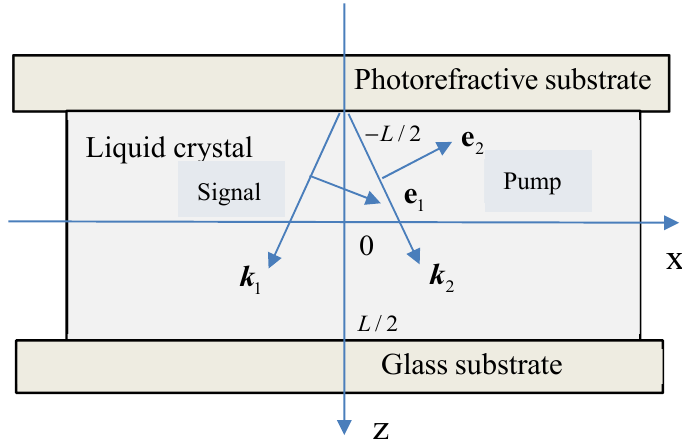
Figure 2. Schematic of the cholesteric liquid crystal (CLC) cell, showing light beams incident from photorefractive medium, together with associated wave and polarization vectors. α 1 , α 2 are the angles of propagation of light beams in the CLC ( α 1 = α 2 ≡ α